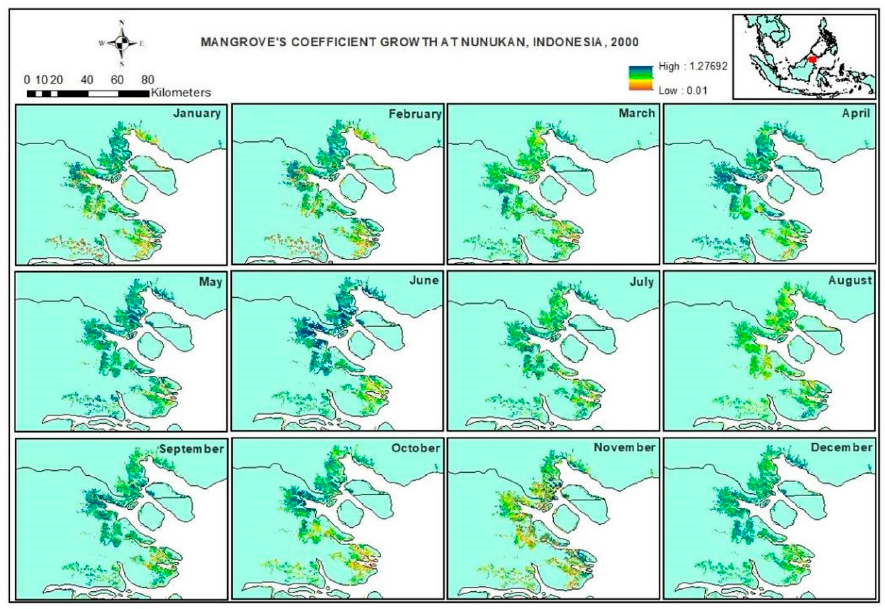
Figure 8. Mangrove coefficient growth (Kc) at Nunukan region, Indonesia, January to December 2000.